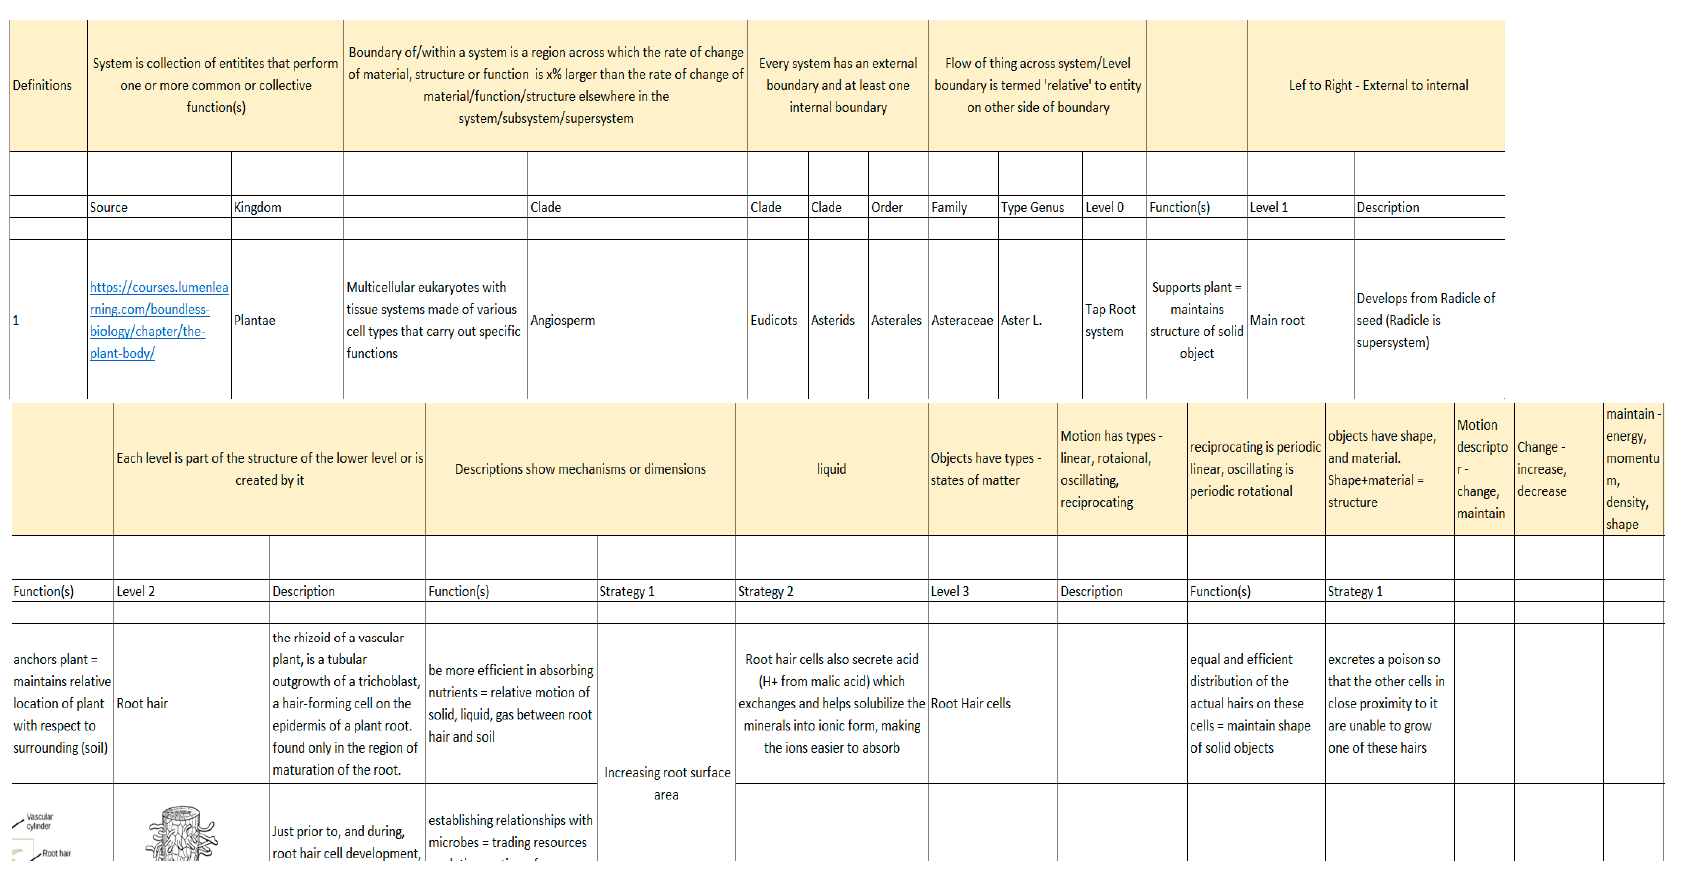
Figure 20. Taxonomy development example using genus Aster L .